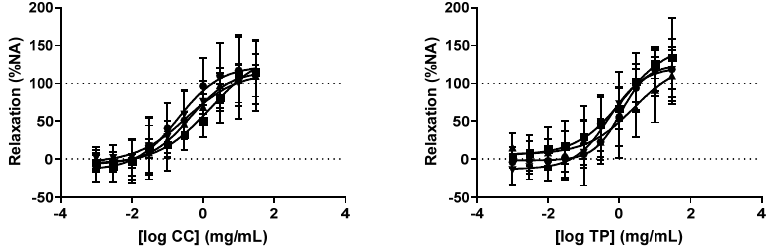
Figure 4. Concentration-response curves for C. canadensis (CC; left) and T. polium (TP; right) in the absence (control condition, circles) and in the presence of L-NAME 100 µ M (squares), Atropine 6 µ M (triangle) or Indomethacin 10 µ M (inverted triangle), on the rat thoracic aorta. Results expressed as % of the contraction induced by noradrenaline 5 μ M. n = 5–7 rats in each group.